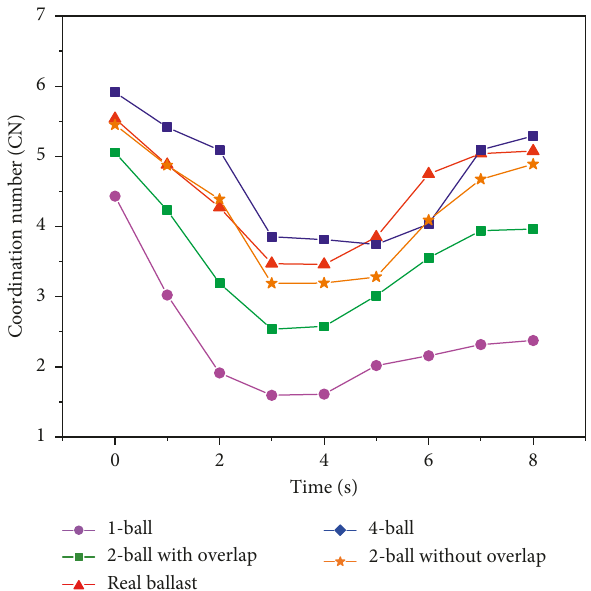
Figure 19: The effect of particle convexity on the coordinate